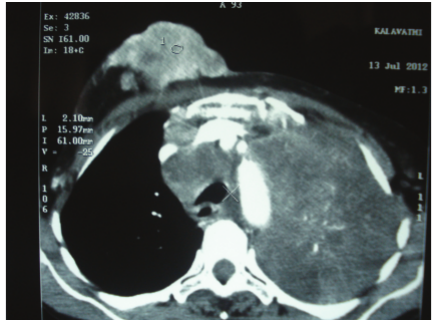
Figure 2: Contrast-enhanced computed tomography (CECT) chest showing left upper lobe lung mass with collapse and left mild pleural effusion. Irregularmassseenintherightbreastwithlossoffat planes between it and the chest wall.